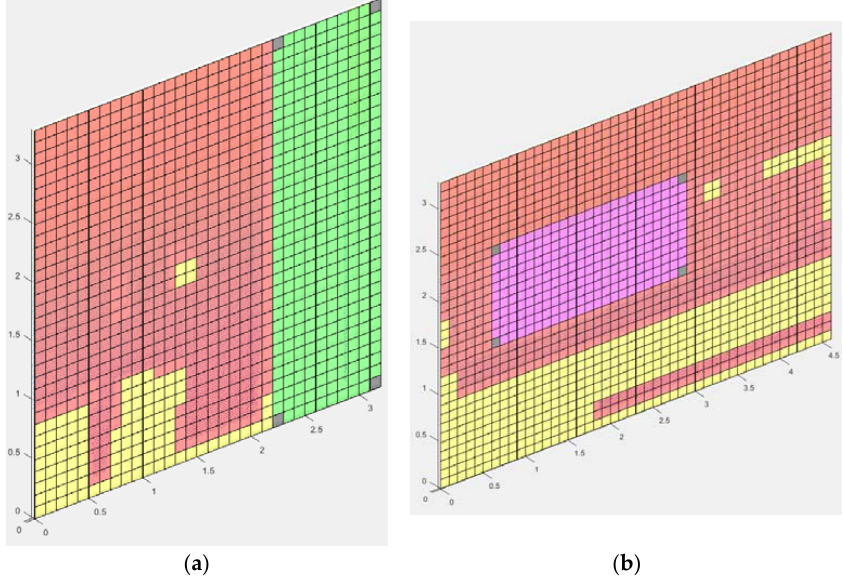
Figure 8. ( a ) Recognized door (green) and corners (grey) (in meters); ( b ) recognized window (magenta) and corners (grey) (in meters).